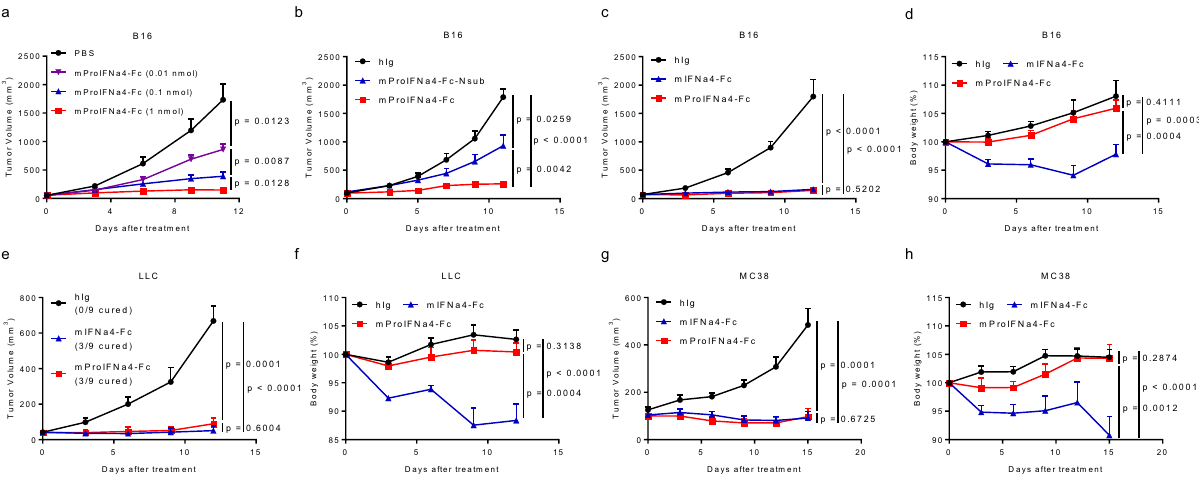
Fig. 3 In vivo assessment of ef fi cacy. a Dose-dependent anti-tumor effect of mProIFNa4-Fc. C57BL/6 J mice were s.c. inoculated with 5 × 10 5 B16 tumor cells and i.p. treated with 0, 0.01, 0.1, or 1 nmol of fusion protein on day 7, 10, and 13 ( n = 10 animals). Tumor volume was shown. b Cleavable linker dependent anti-tumor effect of mProIFNa4-Fc. C57BL/6 J mice were s.c. inoculated with 5 × 10 5 B16 tumor cells and i.p. treated with 1 nmol of hIg, mProIFNa4-Fc without cleavable substrate (Non-sub), or mProIFNa4-Fc on day 8 and 11 ( n = 8 animals). Tumor volume was shown. c , d C57BL/6 J mice were s.c. inoculated with 5 × 10 5 B16 tumor cells and i.p. treated with 1 nmol of hIg, mIFNa4-Fc, or mProIFNa4-Fc, on day 8, 11, and 14 ( n = 10 animals). Tumor growth ( c ) and body weight ( d ) were shown. e , f C57BL/6 J mice were s.c. inoculated with 1 × 10 6 LLC tumor cells and i.p. treated with 1 nmol of hIg, mIFNa4-Fc, or mProIFNa4-Fc, on day 12, 15, and 18 ( n = 9 animals). Tumor growth ( e ) and body weight ( f ) were shown. g , h C57BL/6J mice were s.c. inoculated with 1 × 10 6 MC38 tumor cells and i.p. treated with 1 nmol of hIg, mIFNa4-Fc, or mProIFNa4-Fc, on day 9, 12, and 15 ( n = 9 animals). Tumor growth ( g ) and body weight ( h ) were shown. Data are reported as mean ± s.e.m. Two-way ANOVA was performed to calculate p -values. Source data are provided as a Source Data fi